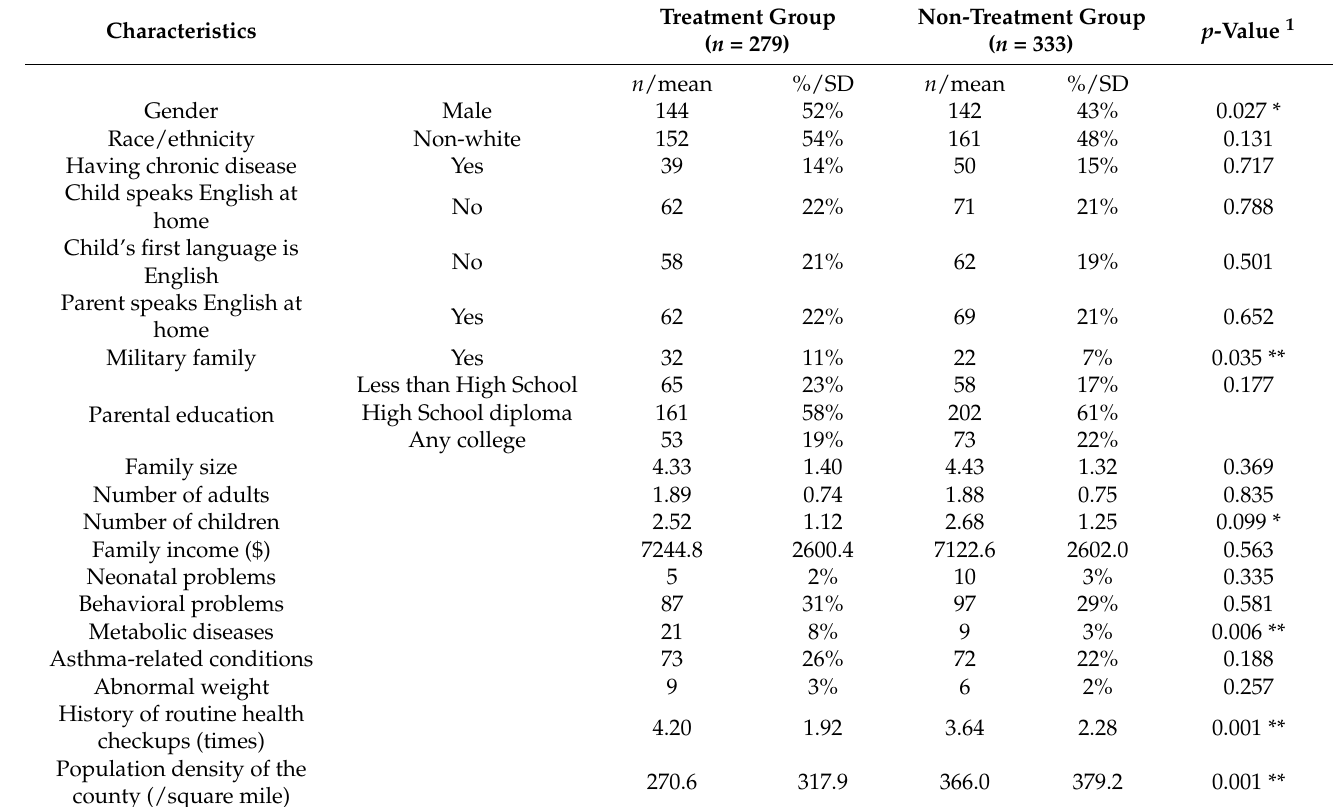
Table 1. Characteristics of the